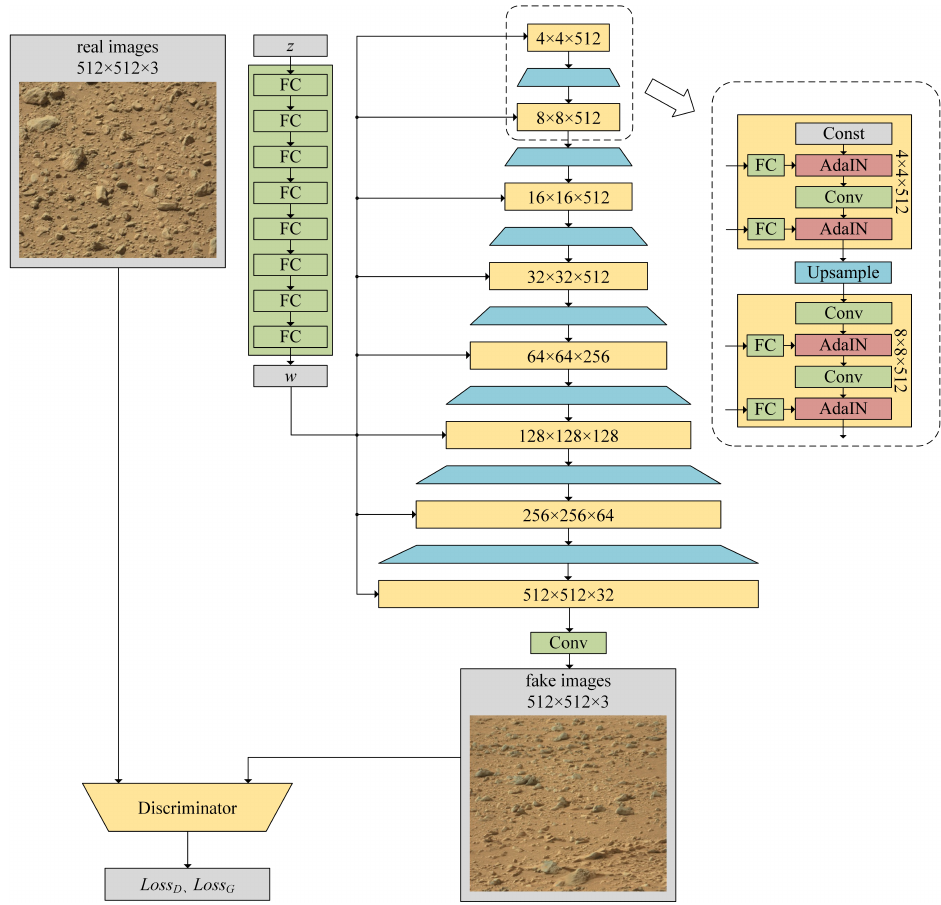
Figure 7. The structure of the GAN, which is being trained to generate Martian rock images. Latent z is mapped to w through an eight-layer fully connected network, and then w is used to control AdaIN operations after each convolution layer. After seven instances of upsampling, the size of the feature map grows from 4 × 4 to 512 × 512. The calculation process of each scale contains two convolution kernels and two AdaIN calculations, except for a 4 × 4 scale which includes one convolution kernel, two AdaIN calculations and one constant. A 512 × 512 × 32 feature map is converted to RGB using a separate 1 × 1 convolution. loss D and loss G are calculated from the output of the discriminator and are used to update the network weights of the discriminator and the generator,